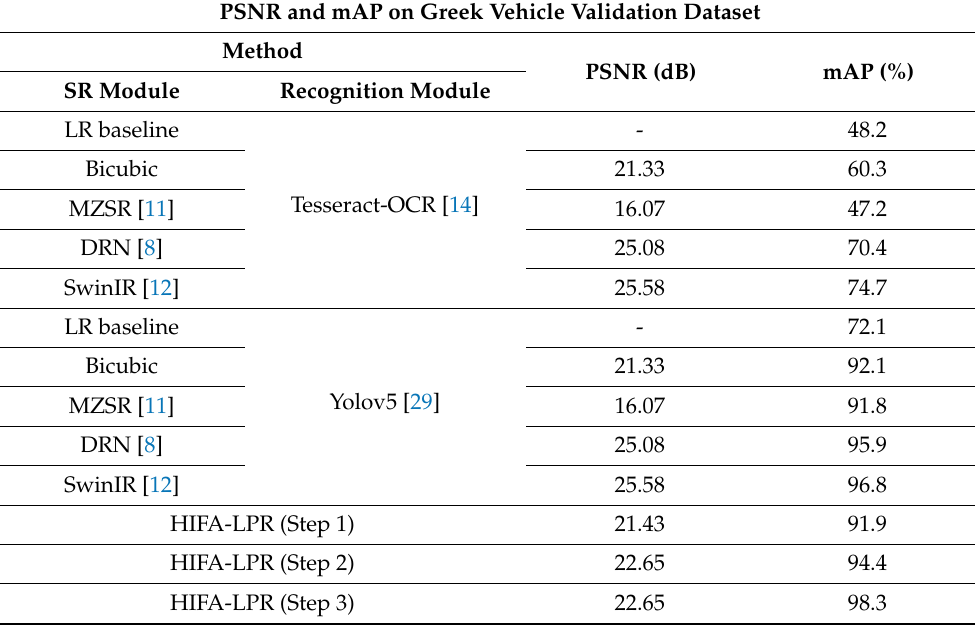
Table 3. Comparison between the HIFA-LPR model and other existing approaches for scale factor ( × 3) on the Greek vehicle dataset.